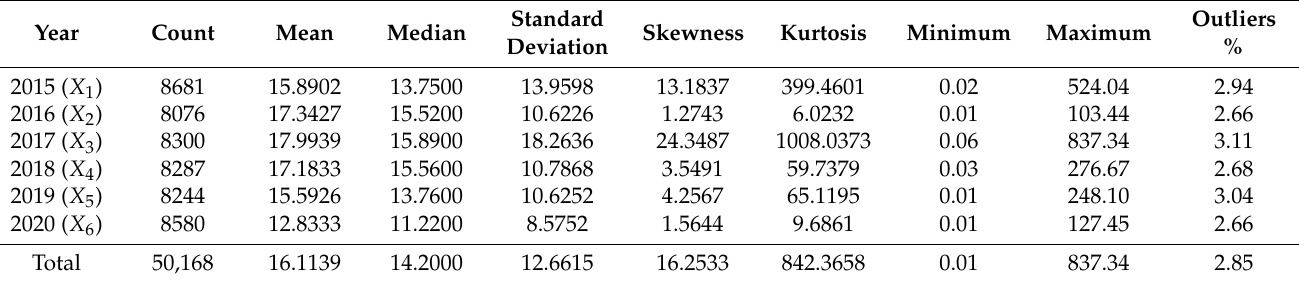
Table 2. Summary